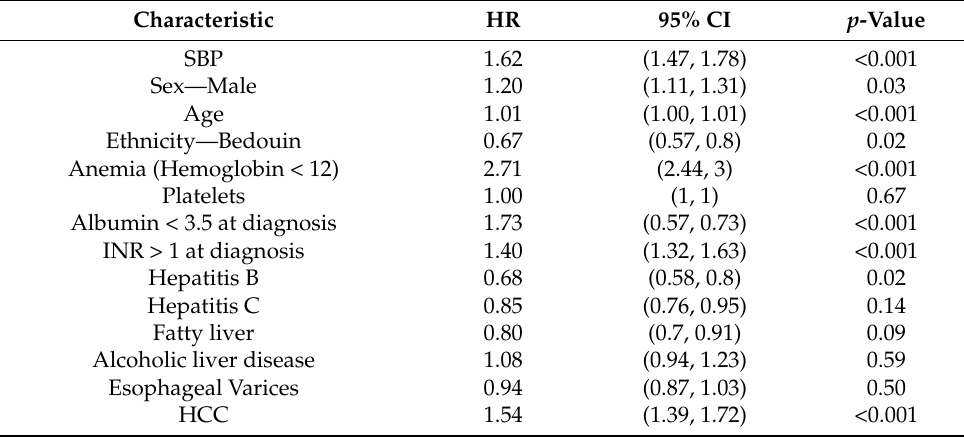
Figure 1. Long-term survival of cirrhotic patients with and without SBP. Table 4. COX regression model for mortality of patients with